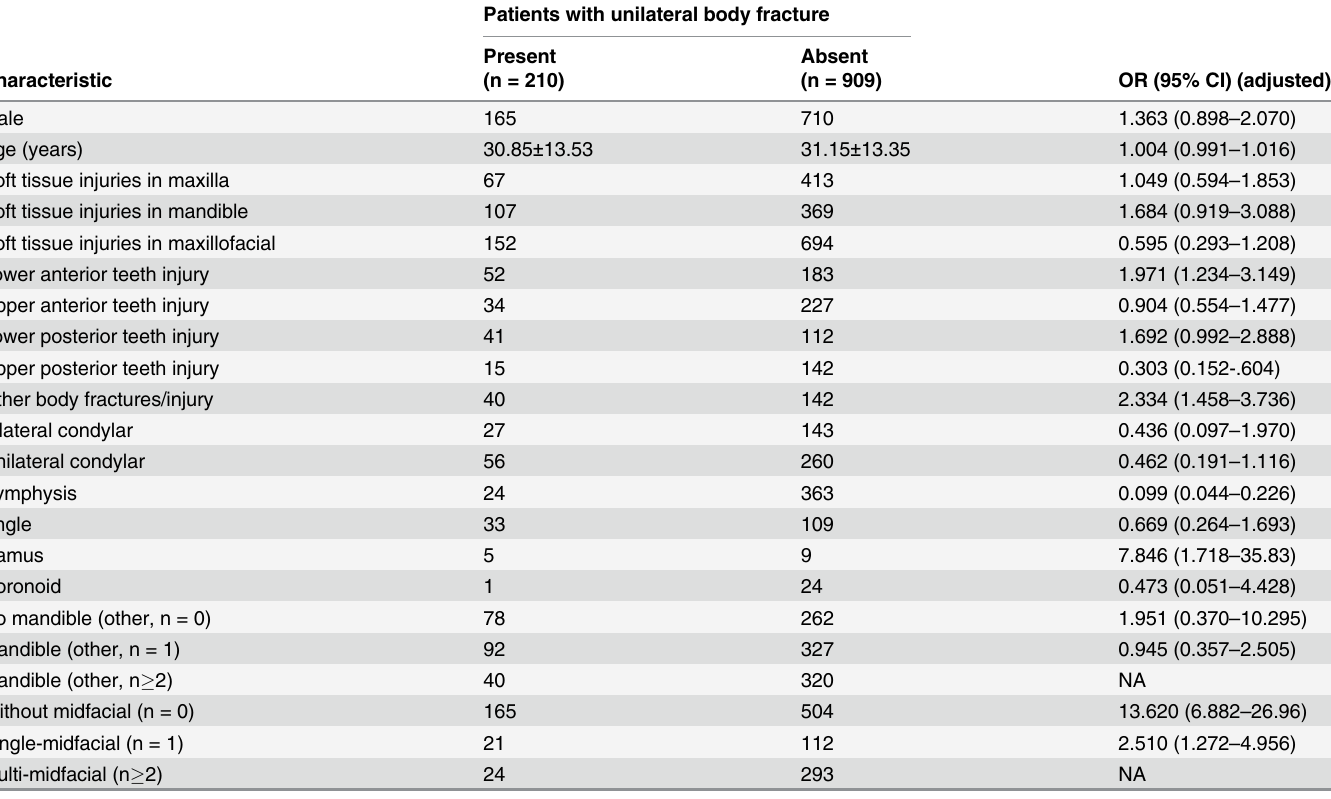
Table 2. Multivariate logistic regression analysis of patients with unilateral mandibular body fractures. Patients with unilateral body